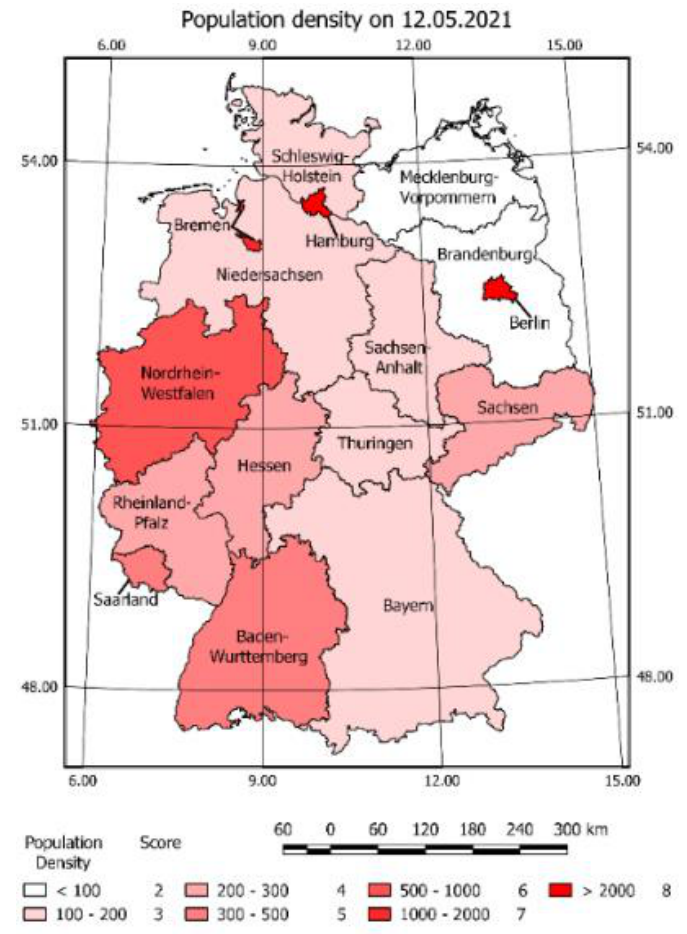
Figure 4. VSc map for population density.